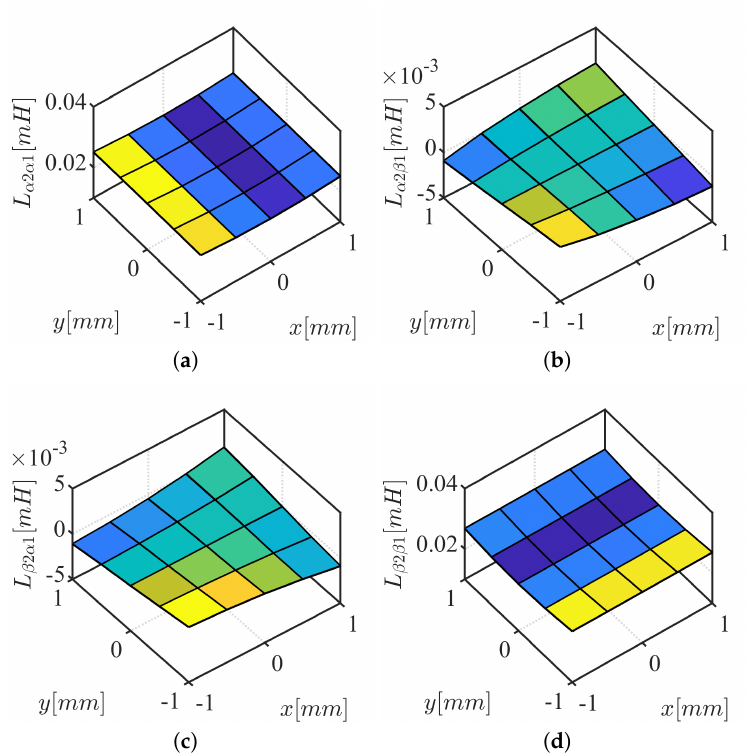
Figure 3. αβ 2 three-phase cross-coupling inductance results from FEA: ( a ) L α 2 α 1 ; ( b ) L α 2 β 1 ; ( c ) L β 2 α 1 ; ( d ) L β 2 β 1